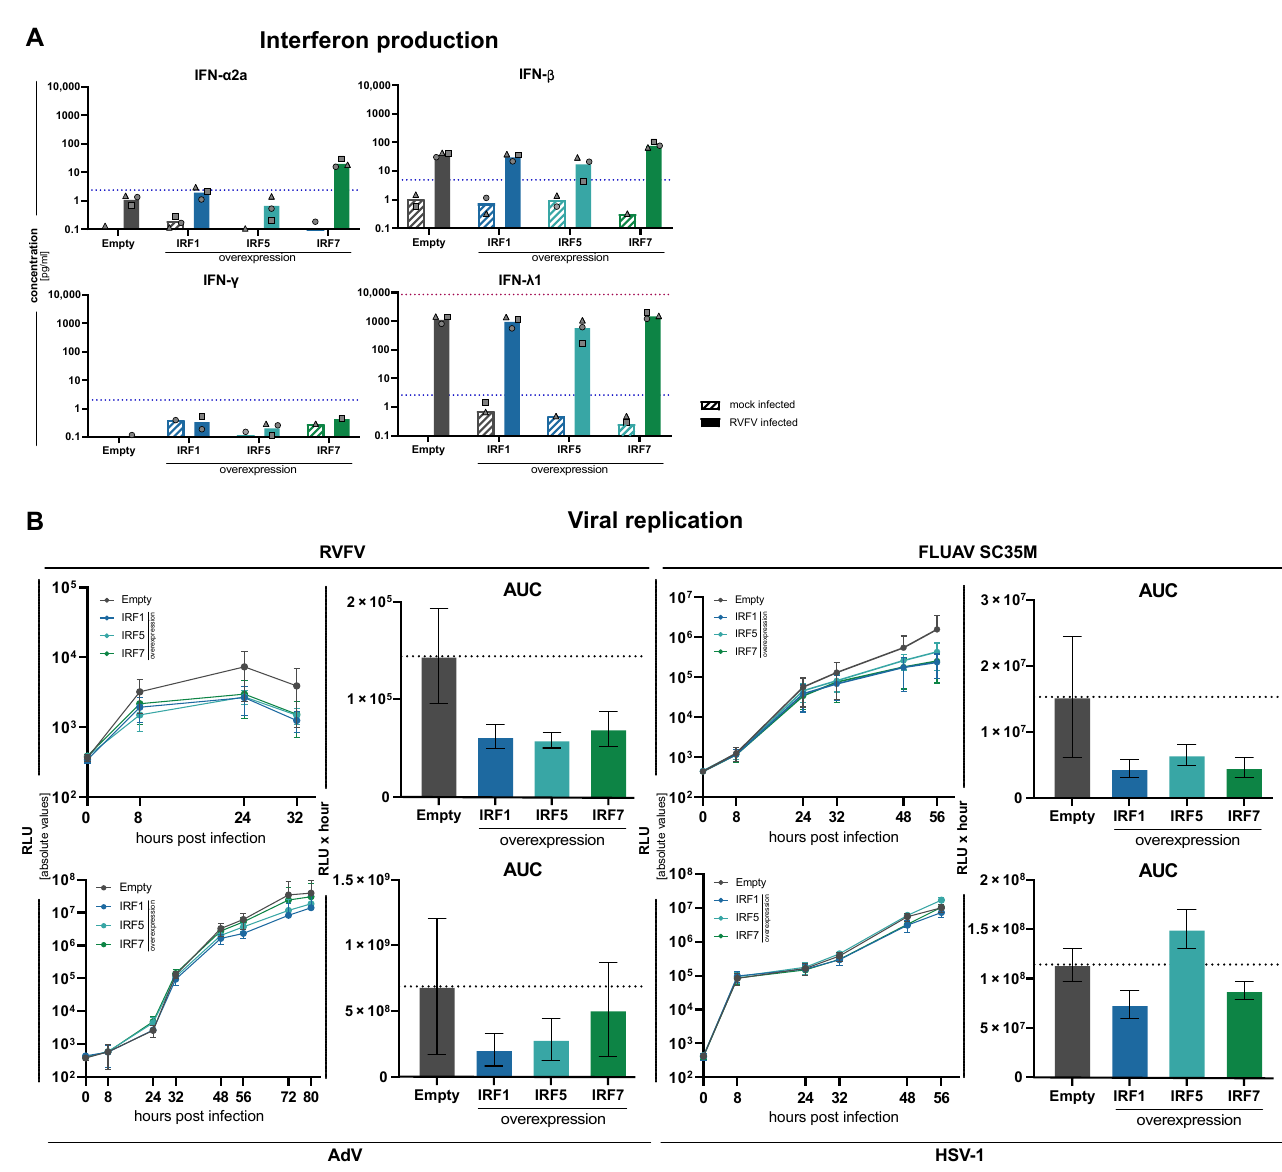
Figure 7. Impact of IRF1, -5 or -7 overexpression on IFN production and virus replication. ( A ) A549 cells stably transduced with an empty lentiviral expression vector or overexpressing IRF1, IRF5 or IRF7 were infected with RVFV (MOI 0.01) for 24 h and supernatants were analyzed for their IFN content by an electroluminescent multiplex assay. Dashed blue lines indicate the lower limit of quantification for the respective analyte. Bars show means of three independent experiments with the three individual data points shown as symbols (same shapes displays individual replicate). Missing symbols indicate individual measurements below the cut-off or non-detectable. ( B ) Empty vector or IRF1, -5 or -7 overexpressing cells were infected with the indicated viruses (RVFV, FLUAV, AdV, HSV-1) and viral replication was assessed by luciferase activity measurements at the indicated time points (left). The area under the curve (AUC) of the replication time courses is given as a bar chart (right). Viral replication time-courses and AUC plots show mean ± SD of three independent